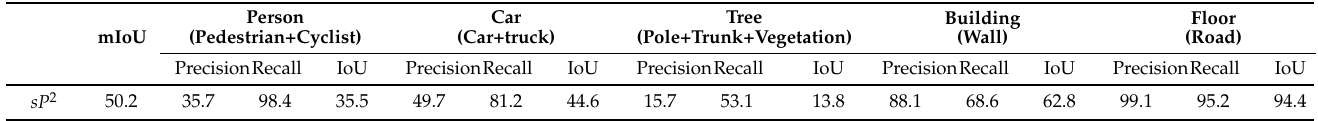
Table 4. Classification performance evaluation of the sP 2